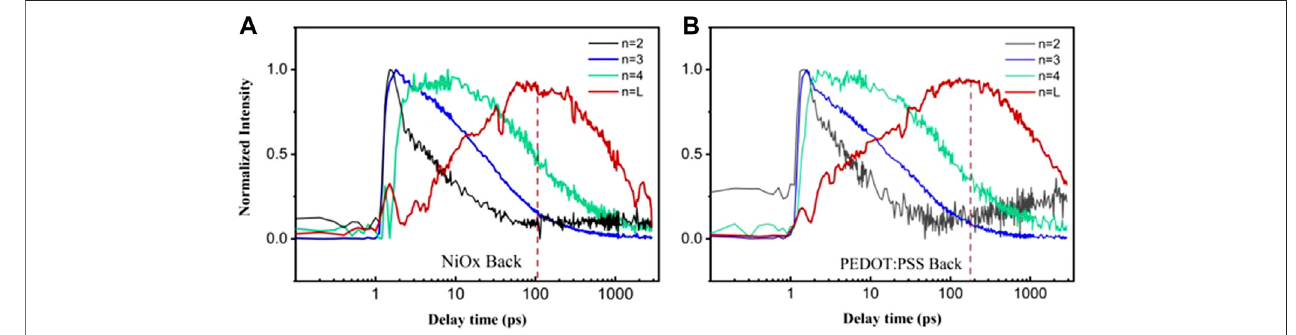
FIGURE 6 | TA kinetics probed at bleach peaks of various n values of the (A) PEDOT:PSS – based fi lm and the (B) NiO x -based fi lm.